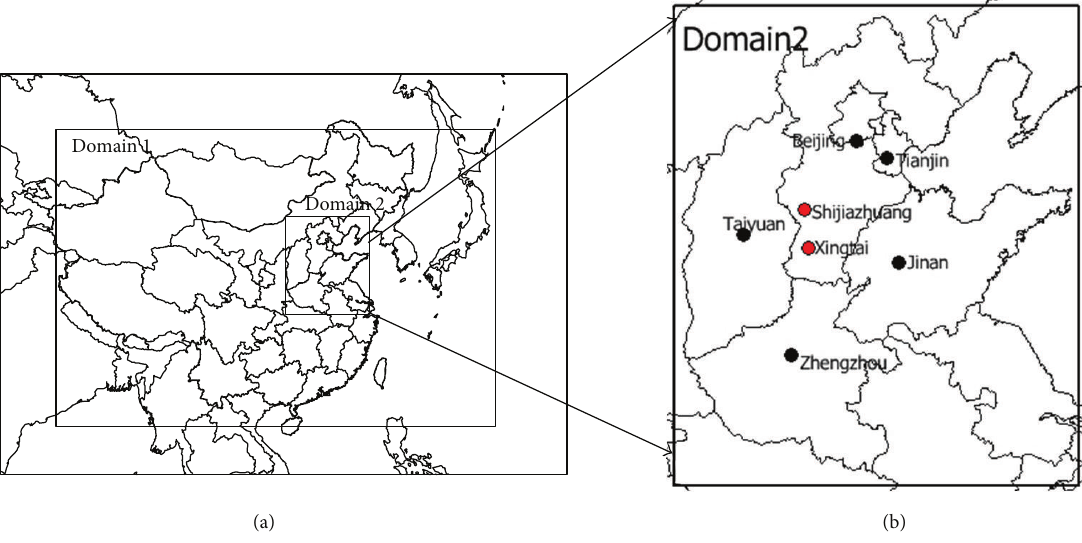
Figure 1: (a) Two domains used in CMAQ modeling. Domain 1: 36km over most of East Asia with 164×97 grids; domain 2: 12km over most of eastern China with 93 × 111 grids. (b) Location of target cities in domain 2 and the range of domain